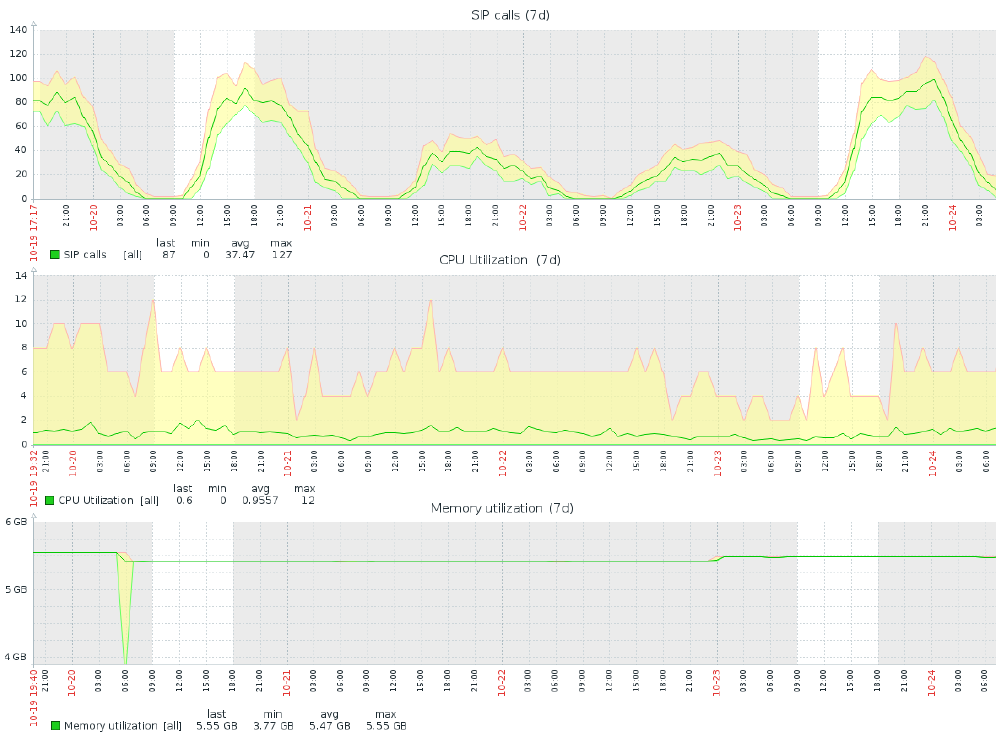
Figure 8. Monitoring statistics for system resources.